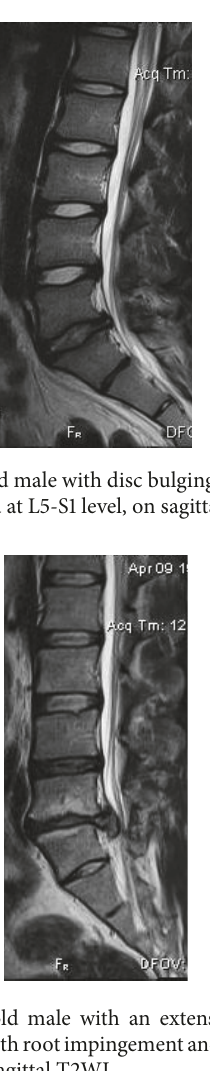
Figure 1: A 17-year-old male with Scheuermann’s disease, depicted onthesagittalT2WI.Thereismultilevelinvolvementofthevertebral bodies, mainly in the lower thoracic spine. Minor anterior wedging, Schmorl’s nodes, endplate irregularities, and disc space narrowing are present. Note the presence of kyphosis.